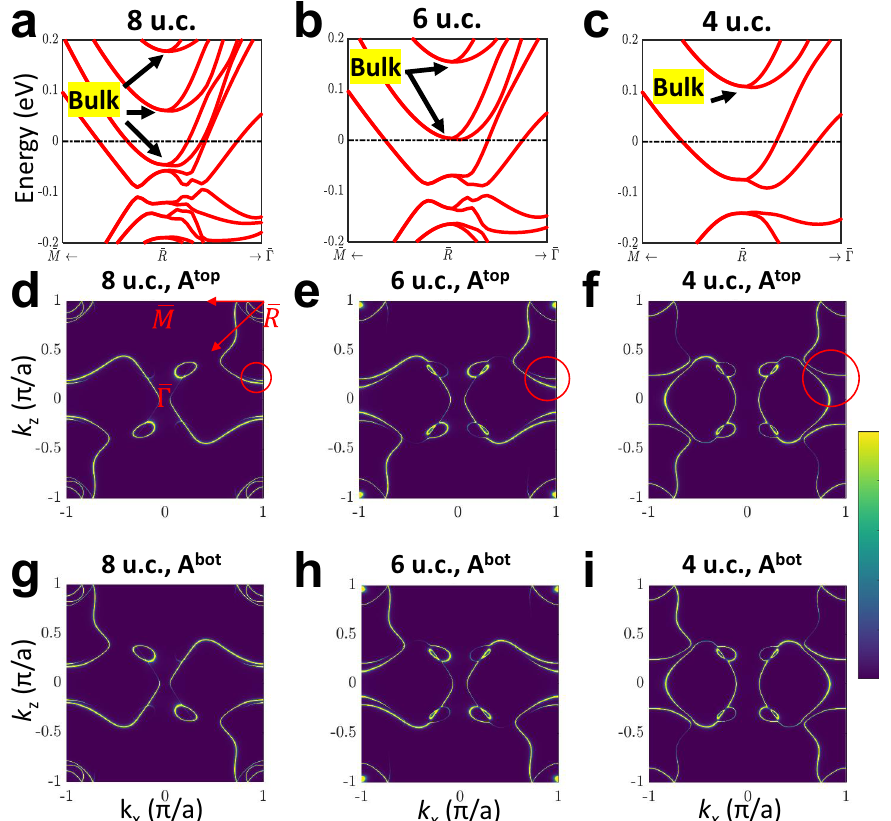
Fig. 5 Band structures and surface-resolved spectral weight of CoSi thin slabs. a – c Band structures near R , for slab thicknesses of 4 unit cells (u. c.), 6 u. c. and 8 u. c. (respectively). The arrows show the evolution of the bottom of the bulk sub-bands near the Fermi level with decreasing thickness. At the critical thickness of 6 u. c., the bottom of a bulk sub-band crosses the Fermi level, giving rise to a van Hove singularity in the density of states at the Fermi level. Below 6 u. c., the only bands left at the Fermi level are the remnant of the Fermi-arc states. d – i Electronic ) and bottom 2 layers ( A bot ) in 4 u. c., 6 u. c., and 8 u. c CoSi slabs with the color scale in arbitrary unit. spectral functions of the top 2 layers ( A top k k The two spectral functions are related by a C 2 rotation. In the thinnest samples, the Fermi-arc remnant states are spread rather uniformly over ’ A bot . The red circles in d – f indicate the splitting of Fermi arcs due to top and bottom surface the entire fi lm volume, thereby yielding A top k k hybridization. The thinner the slab, the larger the